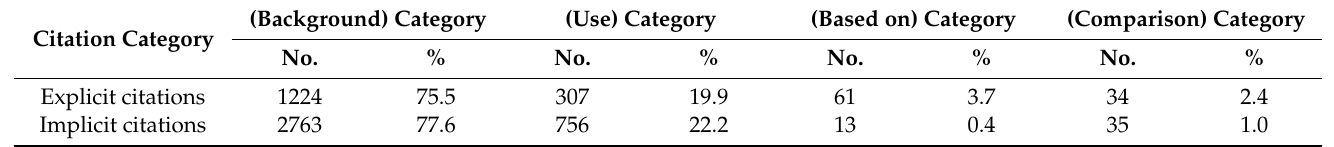
Table 9. Distribution of different citation functions in explicit citation sentences and implicit citation